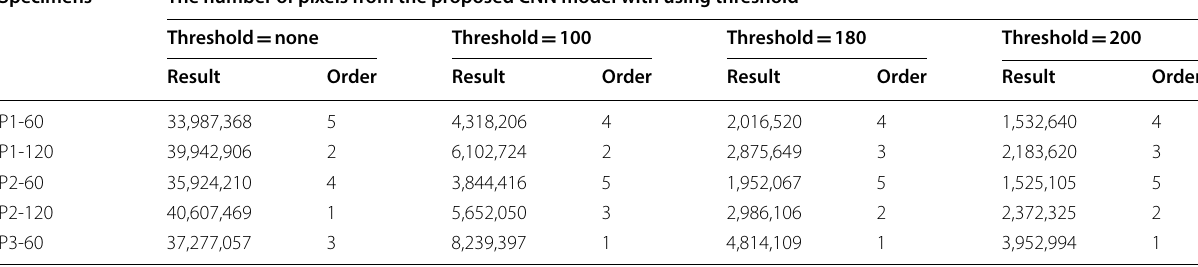
Table 5 CNN results depending on various threshold values.